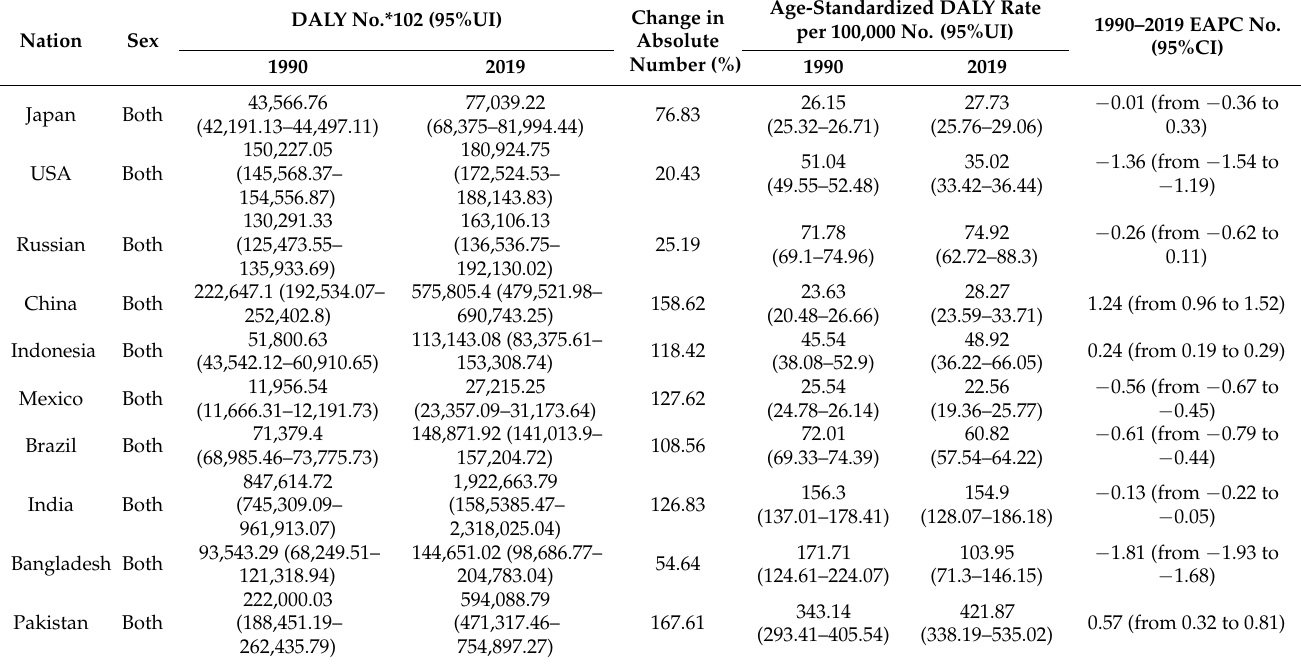
Table 3. The DALY and age-standardized DALY rate of Oral cancer in 1990 and 2019, and its temporal trends from 1990 to 2019. (Countries are ranked from highest to lowest in